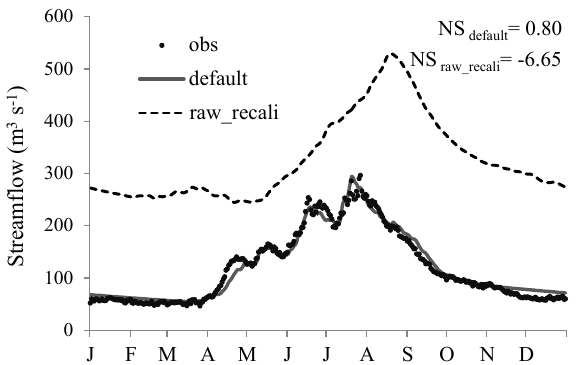
Figure 3. Mean annual hydrographs of observed streamflow (obs) and simulated streamflow using observed meteorological data (de- fault) during the period of 1986 ∼ 2001 at the Dashankou Station. The simulated streamflow using raw RCM-simulated meteorologi- cal data after recalibration (raw_recali) is also plotted. The NS val- ues are for the daily continuous data and not for the mean hydro-